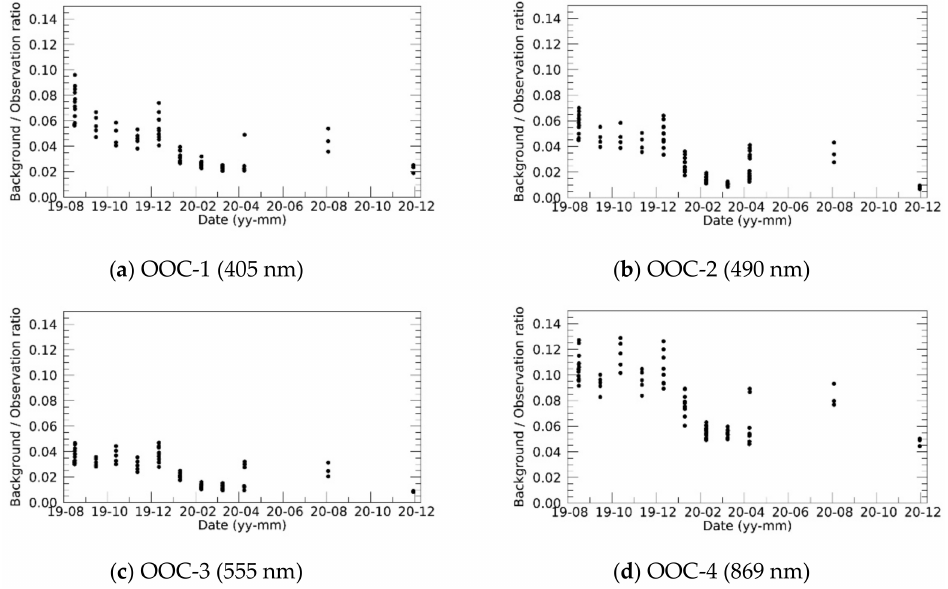
Figure 12. Temporal changes in the background-to-observation irradiance